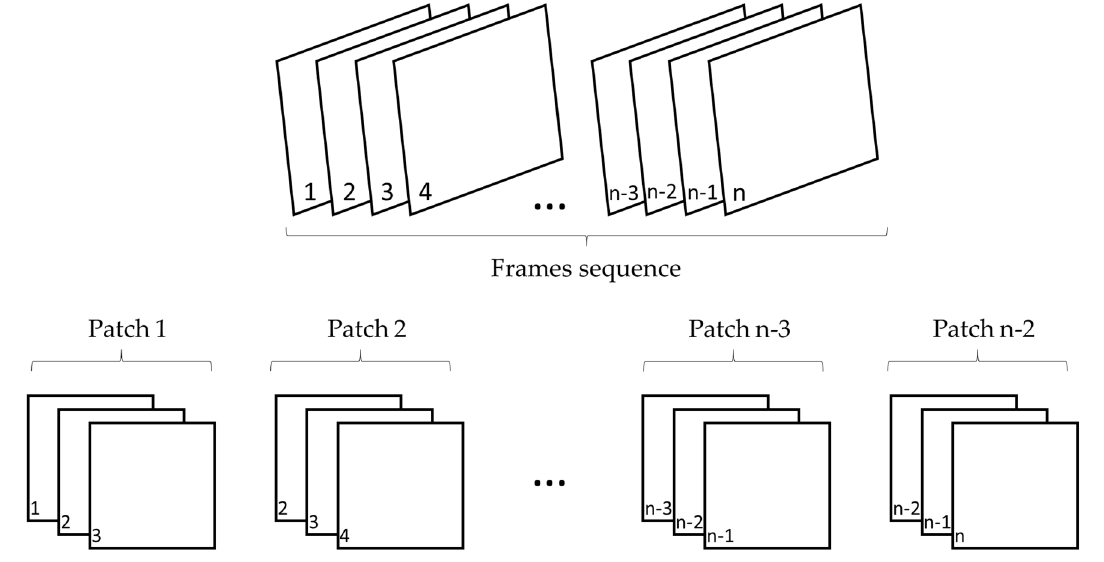
Figure 1. The method for grouping frames into correlated patches. Here, the neighbors share some same frames.